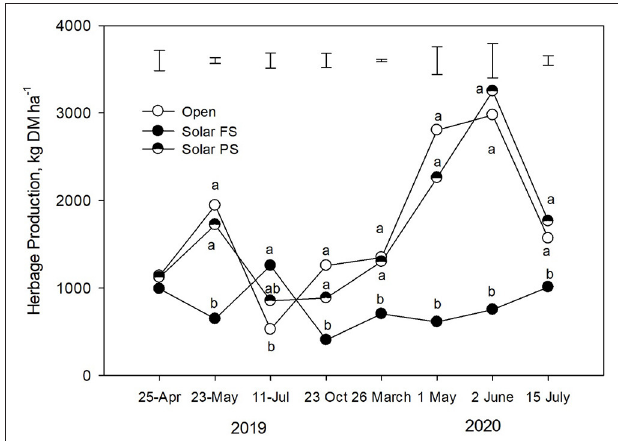
FIGURE 2 | Seasonal herbage dry matter (DM) production (kg DM ha − 1 ) in fully (FS) and partially shaded (PS) areas under solar panels and open pastures in 2019 and 2020. a − b Lowercase letters indicate statistical differences for total herbage production according to Fisher’s unprotected least significant difference ( α = 0.05). Bars represent